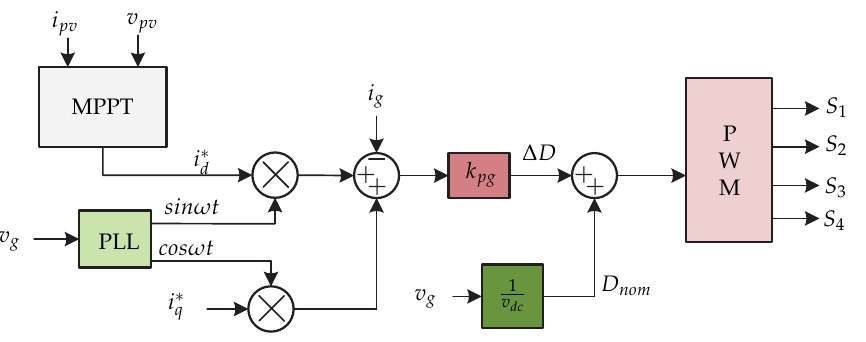
Figure 33. Control strategy proposed in [25].